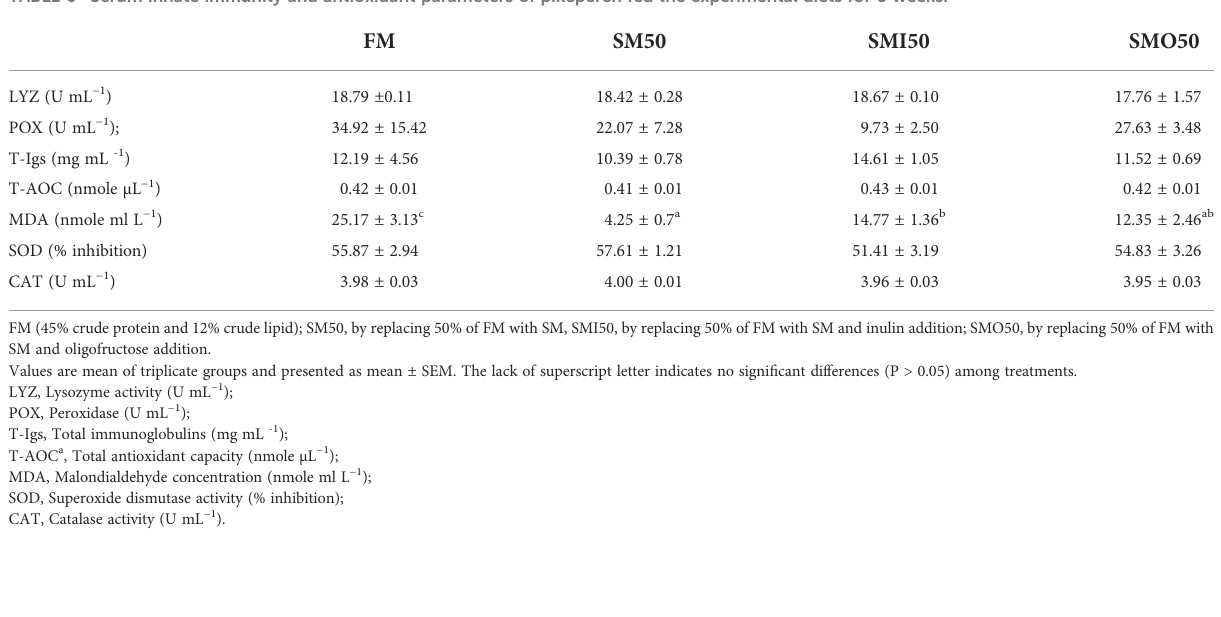
TABLE 6 Serum innate immunity and antioxidant parameters of pikeperch fed the experimental diets for 8 weeks.